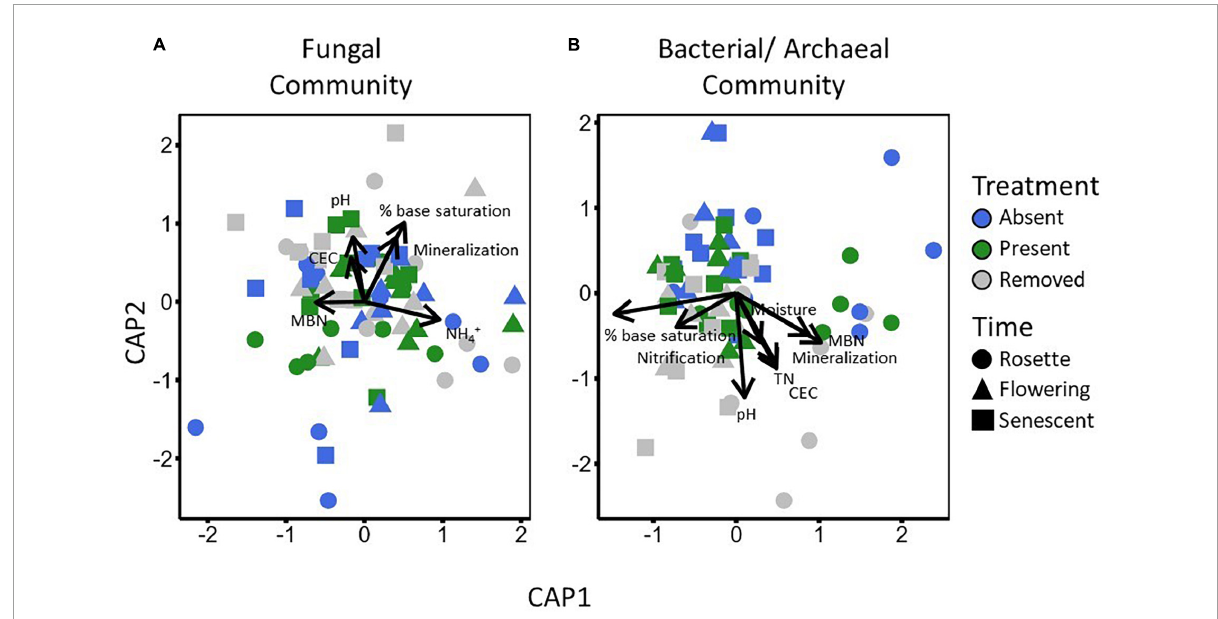
FIGURE5 Vector scaling analysis of environmental and N-cycling variables against constrained PCoA ordinations for fungal (A) and bacterial/archaea (B) communities. Arrows represent variables with significant correlations to microbial community ordinations, with the length of each arrow roughly proportional to the R 2 of its RDA